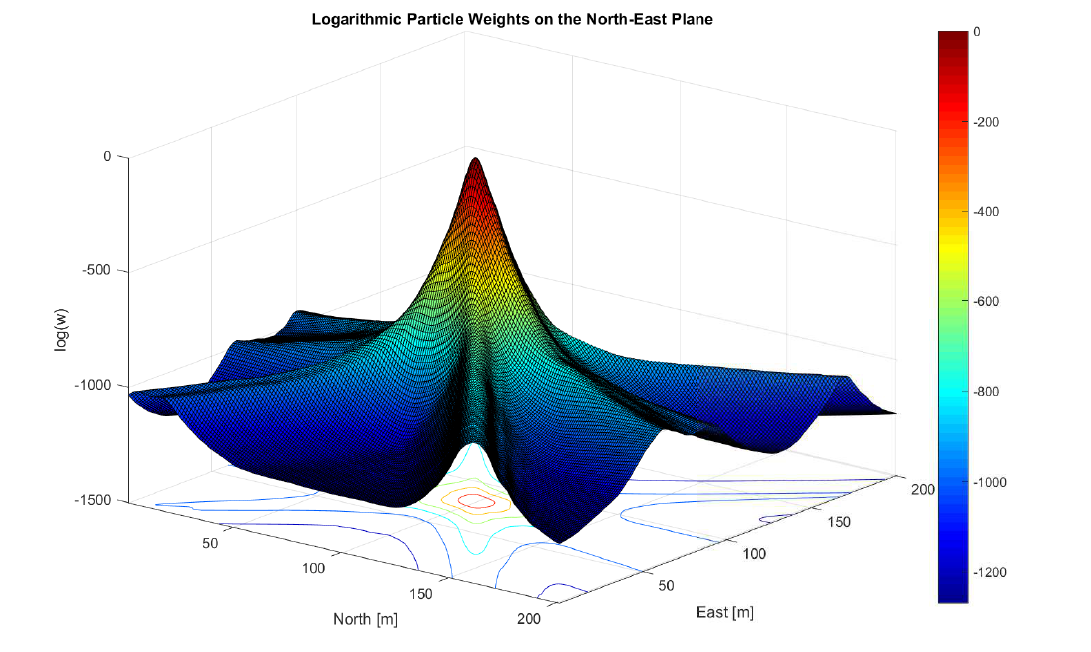
Figure 2. The normalized logarithmic particle weights (cid:101) w i from Equation (35), assuming a uniform k = 0 and using the optimal particle weight update from distribution from the previous epoch, i.e., (cid:101) w i k − 1 Equation (34) are shown. The particles are equidistantly distributed over a grid in the northeast plane. The lines through the plot correspond to the weighted correlation function in the position domain and thus refer to a GNSS signal. In a proper case (correct user velocity, clock error and drift), the lines overlap at a distinct point in the position domain, which is in this case the northeast plane. The resulting peak represents the probability of the 2D position. Note that the plotted weights are normalized and in the logarithmic scale, thus the peak has the maximum value of 0. The coherent integration time for this plot was set to T coh = 2 ms. The processed data refers to open sky. It was recorded at latitude LAT = 47.06446263 deg, longitude LON = 15.40777110 deg on the rooftop of Reininghausstraße